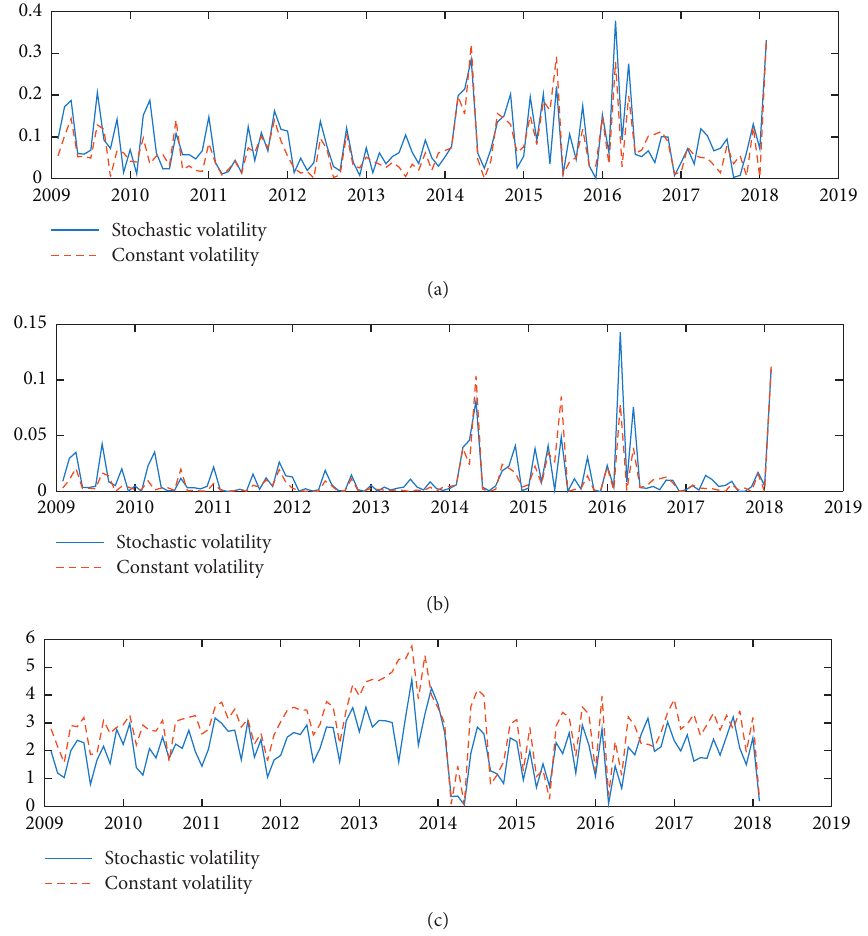
Figure 1: Forecasting performance measurement of models with LASSO prior on constant and time-varying coefficients, h � 1. (a) is the absolute forecast errors, (b) is the forecast errors squared, and (c) is the log predictive likelihood.